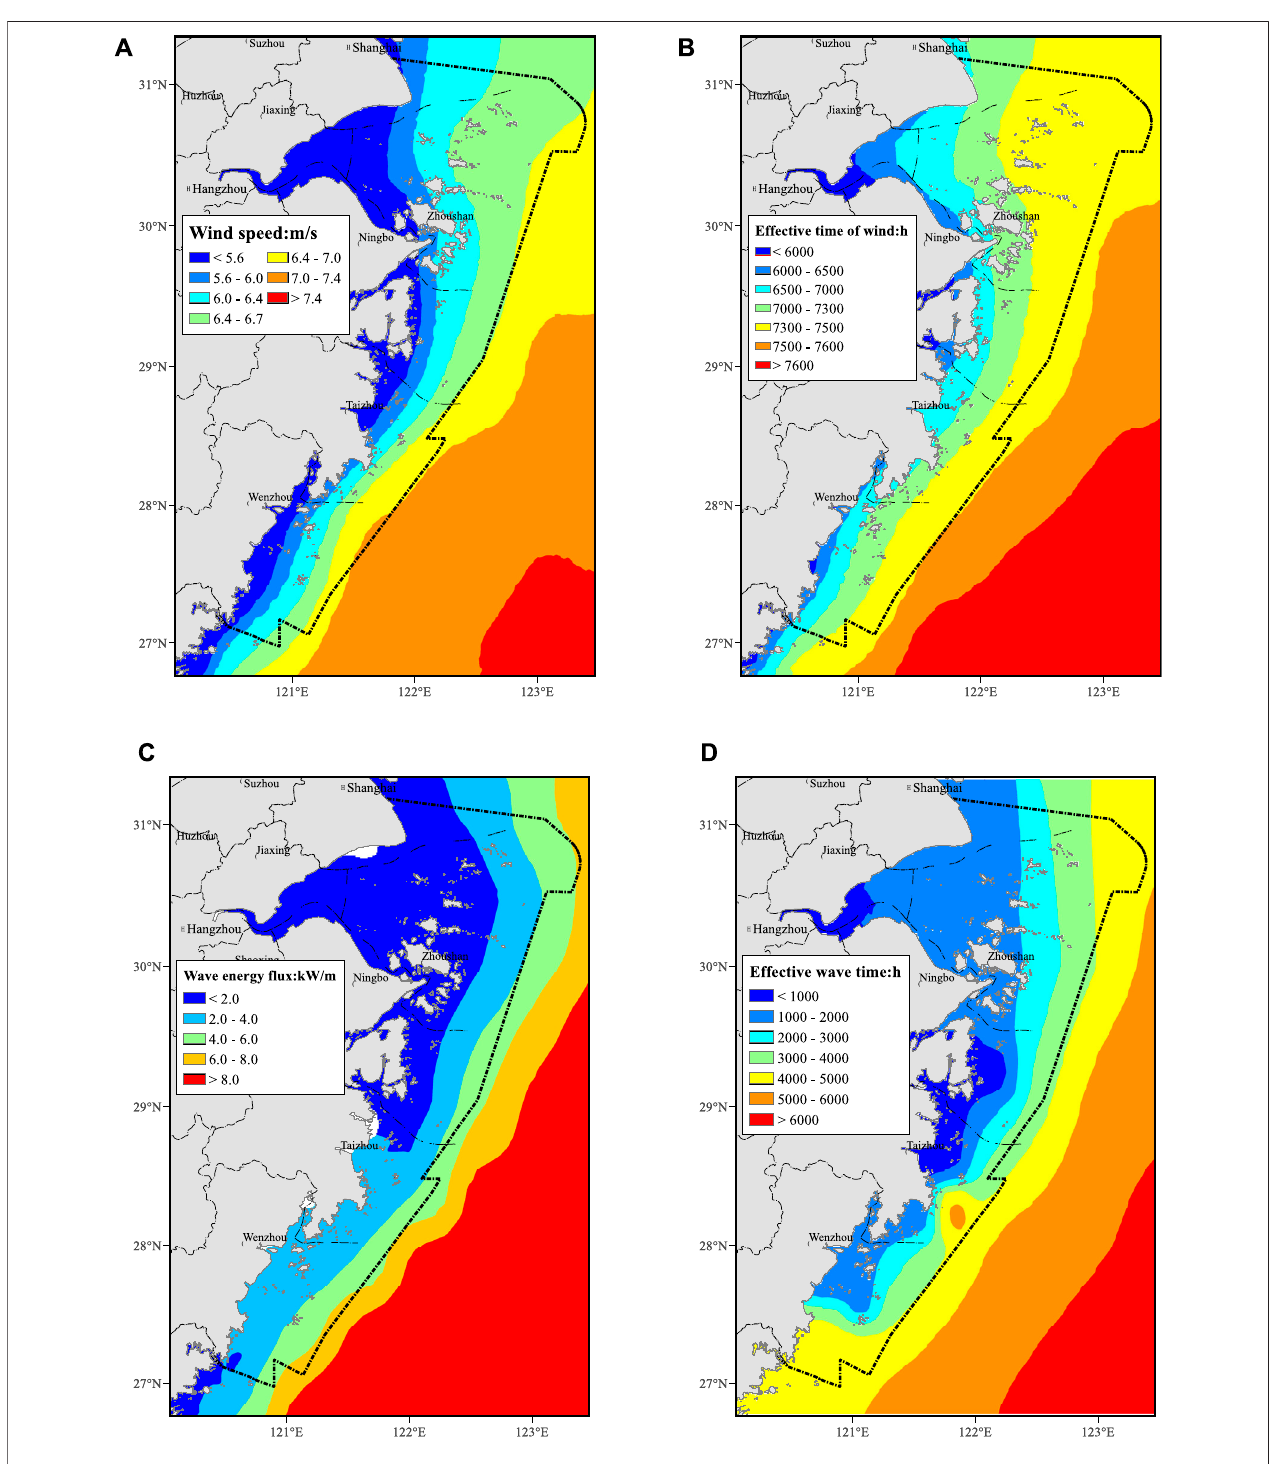
FIGURE2 | Spatial distribution ofthe annual mean in Zhejiang Province. (A) Annual average wind speed, (B) effectiveoffshore wind time, (C) annual average wave energy density, and (D) effective wave time, for the period 1986 – 2015.